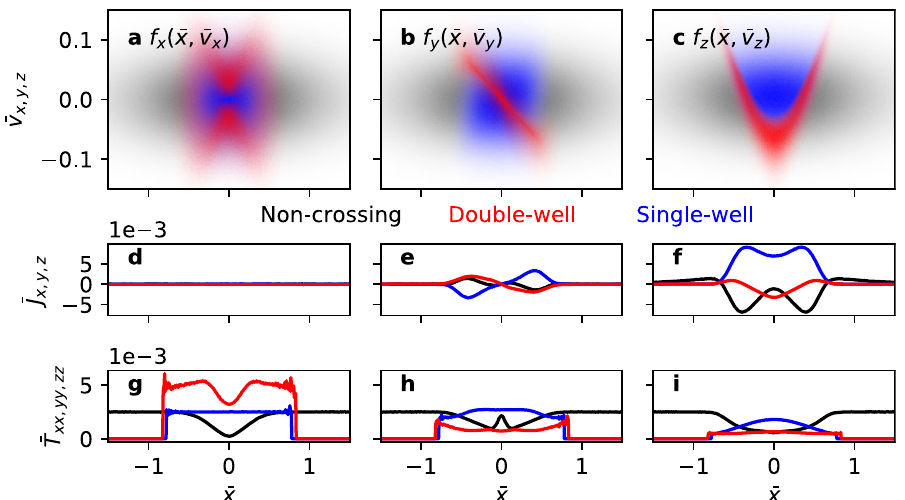
Fig. 3 | Particle distributions in phase space and their moments. Phase-space distributions of the three orbit classes distinguished by the black (non-crossing), red (double-well), and blue (single-well) colors in a (cid:2) x , (cid:2) v x